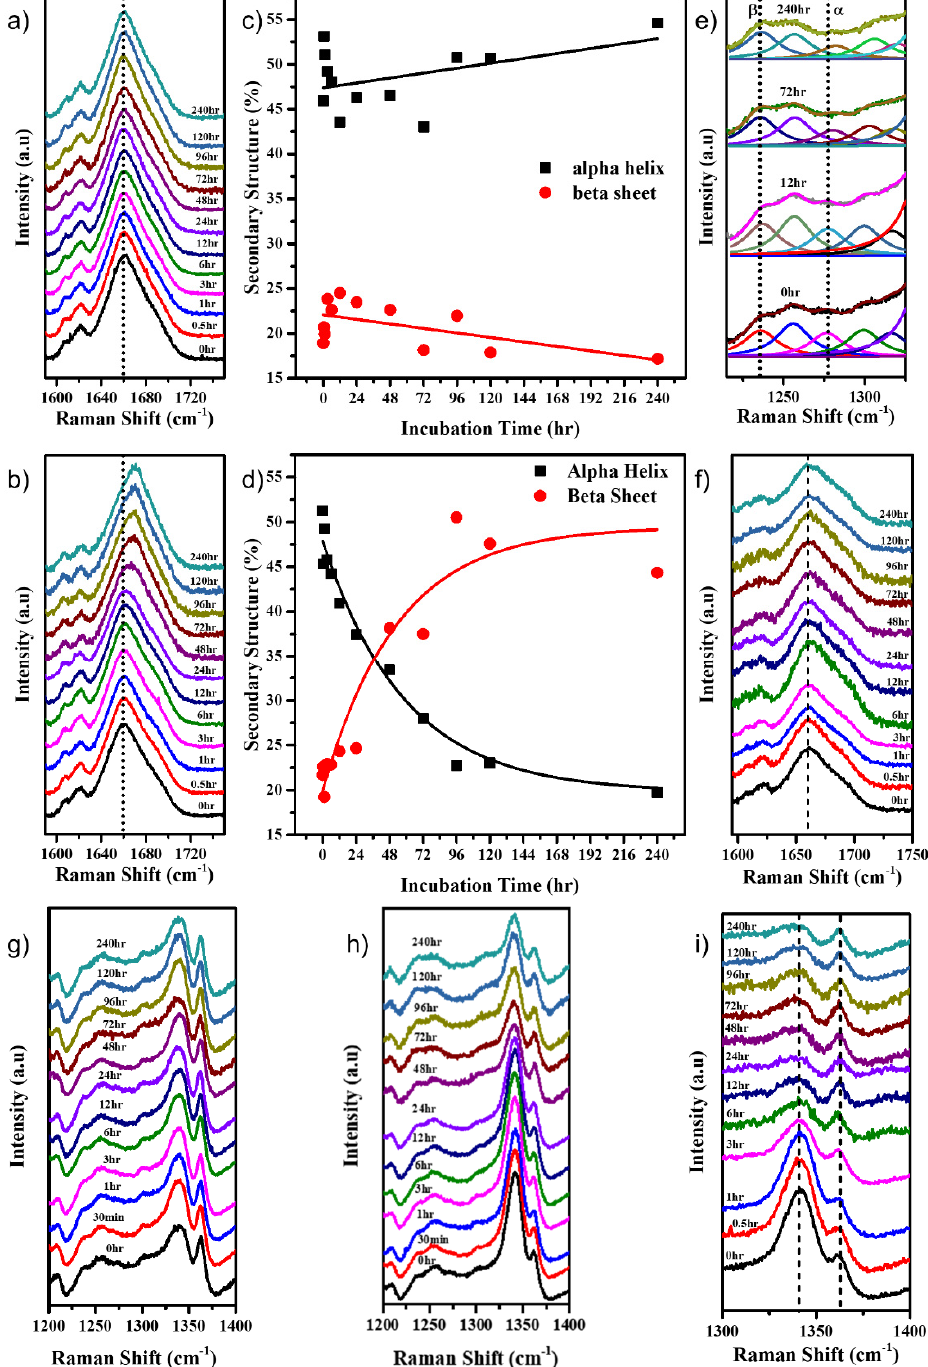
Figure 3. Stack plot of the Amide I Raman band of HEWL in ( a ) pH 7.0 and ( b ) pH 12.2; % α -helical and β -sheet content of the HEWL protein incubated in ( c ) pH 7.0 and ( d ) pH 12.2; ( e ) stack plot with Lorentzian fitting of the Amide III Raman band at selected time points for HEWL incubated in pH 12.2; ( f ) stack plot of Amide I Raman band of HEWL incubated in pH 12.2, with iodoacetamide added to it. Stack plot of the 1341 cm − 1 and 1363 cm − 1 doublet peaks of HEWL in ( g ) pH 7.0, ( h ) pH 12.2, and ( i ) pH 12.2 with iodoacetamide.